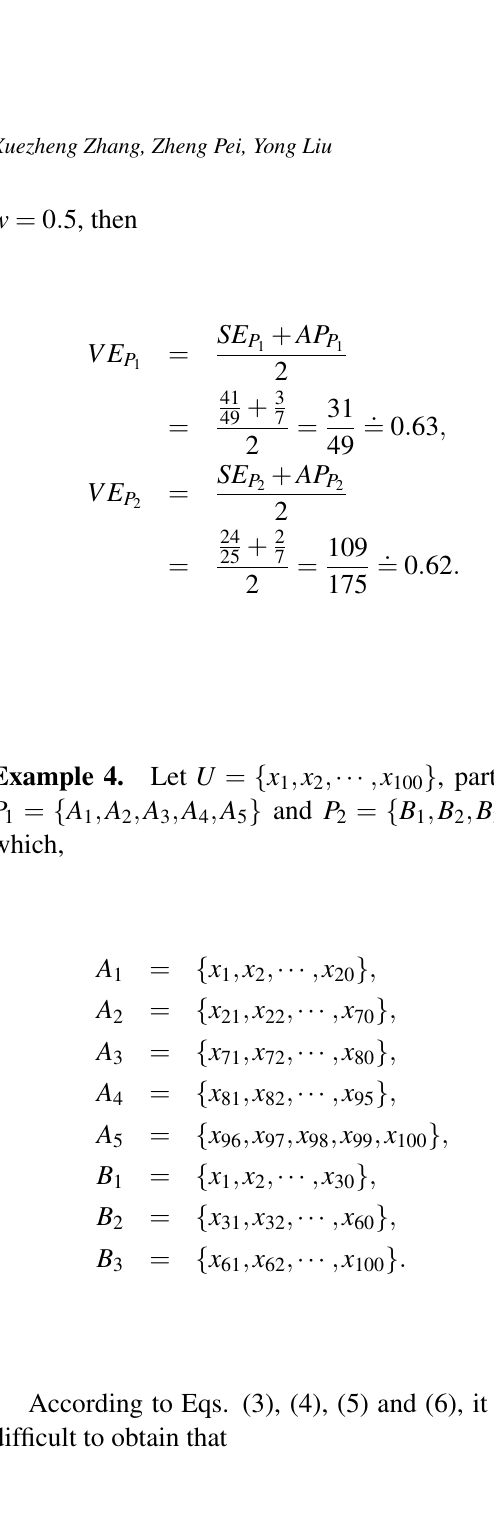
Table 1. Evaluating data based on air and water.